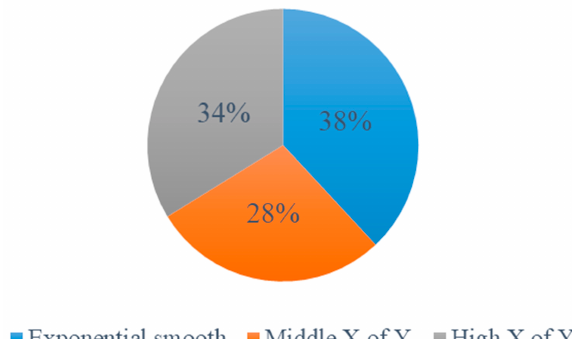
Figure 6. Distribution of tested methods for the Type-1.